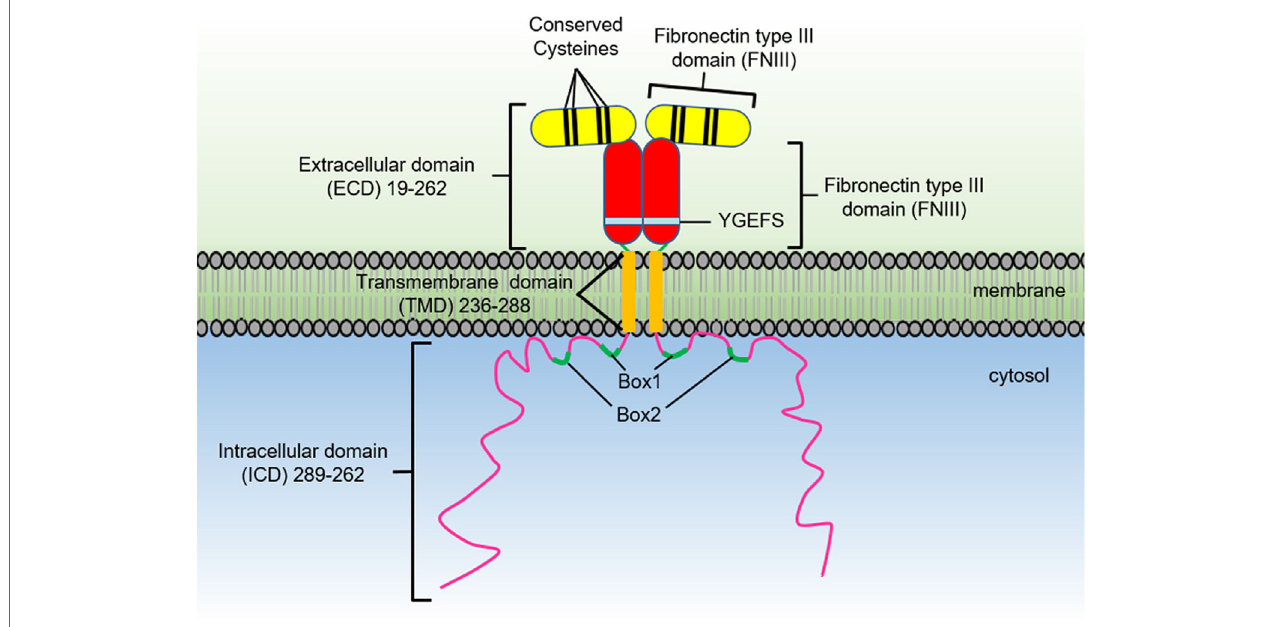
FiGURe 1 | The growth hormone receptor domain